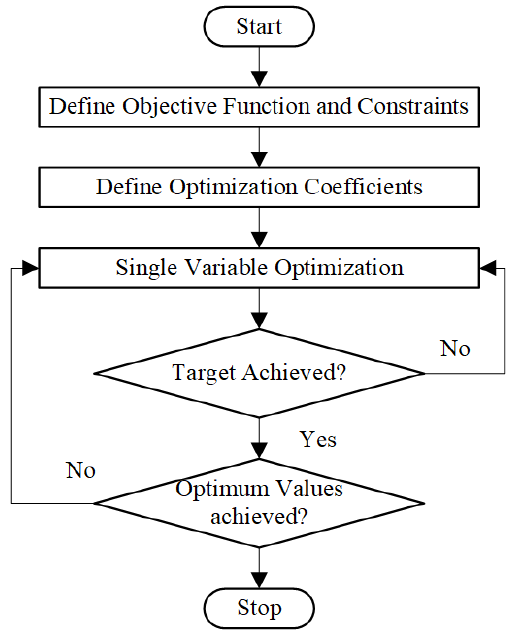
Figure 14. Flow chart of geometric optimization. Table 3. Split ratio